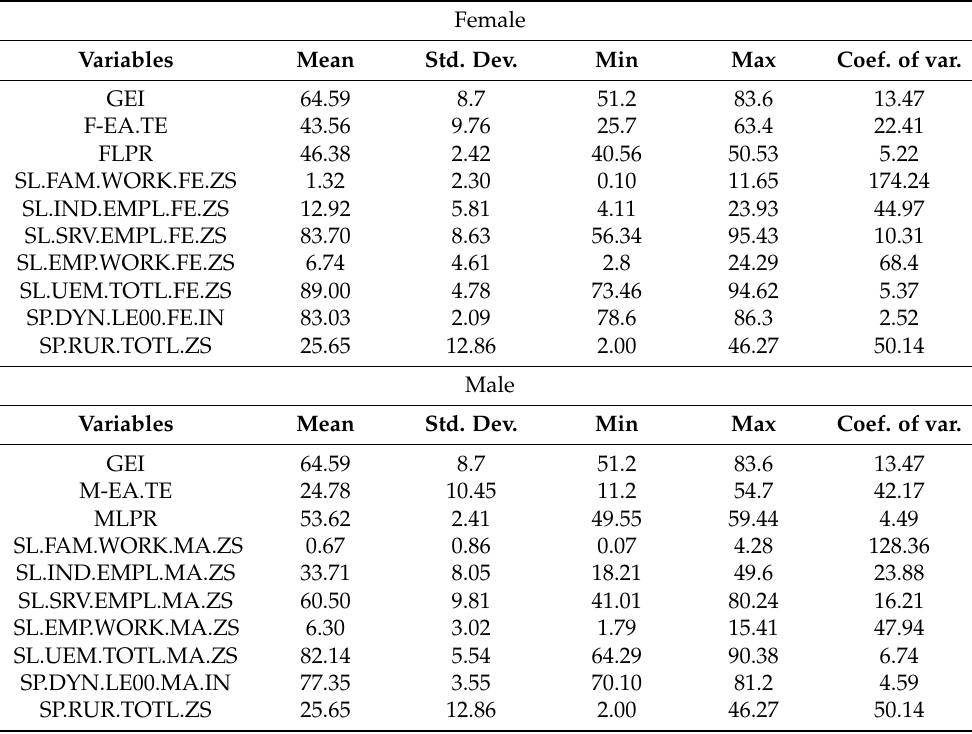
Table 2. Summery statistics of the items used in evaluating the differences among female and